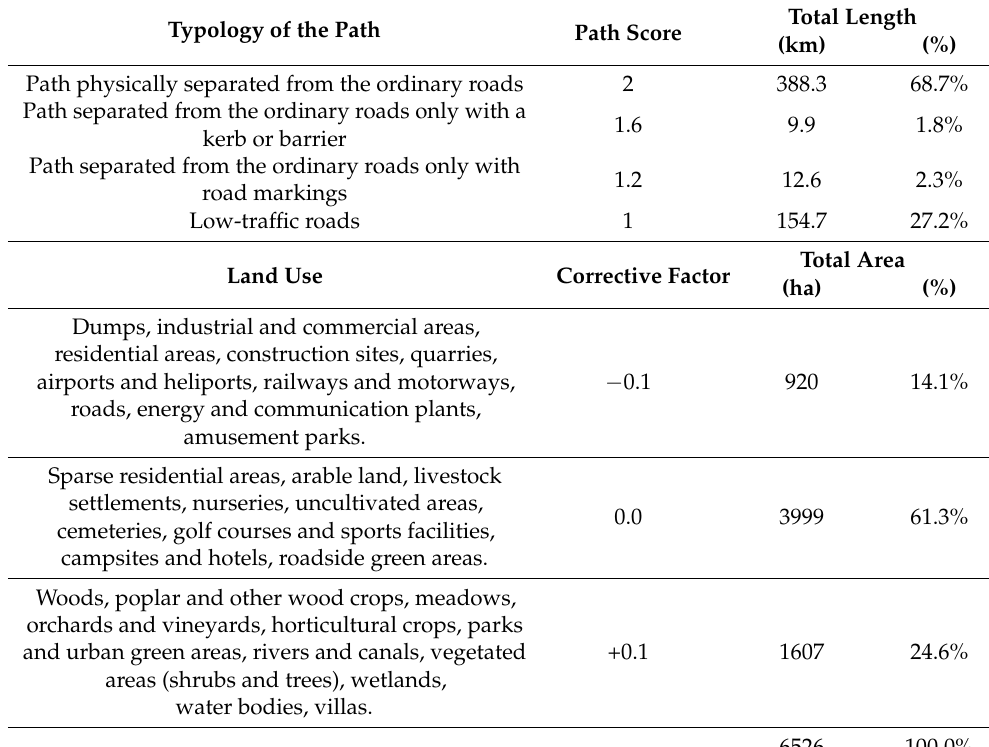
Table 3. Different path typologies and land-use classes in the study area. Typology of the Path Path Score